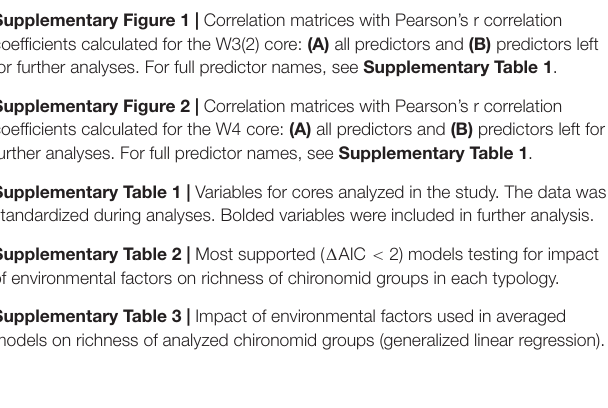
Supplementary Figure 1 | Correlation matrices with Pearson’s r correlation coefficients calculated for the W3(2) core: (A) all predictors and (B) predictors left for further analyses. For full predictor names, see Supplementary Table 1 . Supplementary Figure 2 | Correlation matrices with Pearson’s r correlation coefficients calculated for the W4 core: (A) all predictors and (B) predictors left for further analyses. For full predictor names, see Supplementary Table 1